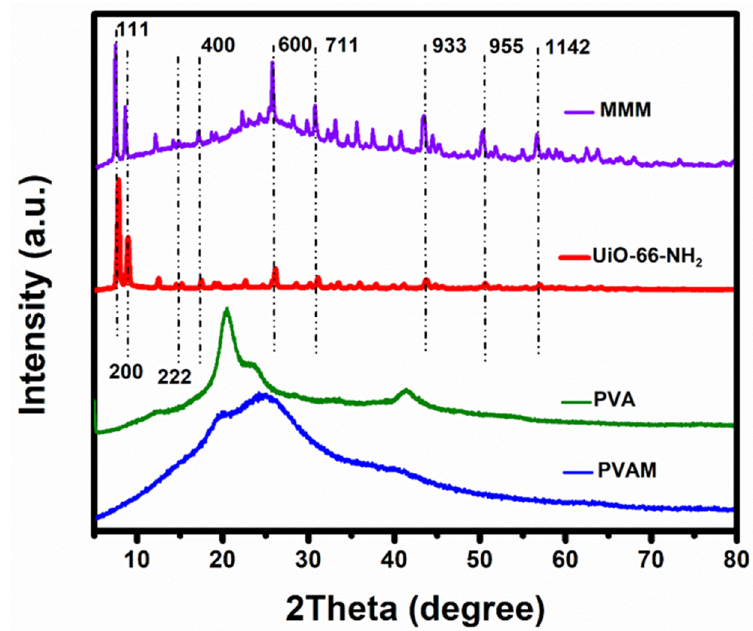
Figure 5. XRD spectra of fabricated MMM and the synthesized UiO-66-NH 2 MOF.